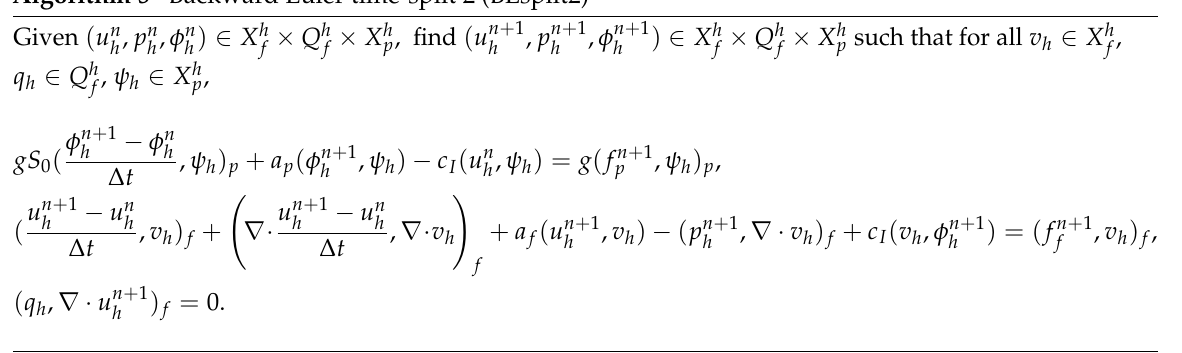
Algorithm 5 Backward Euler time-split 2